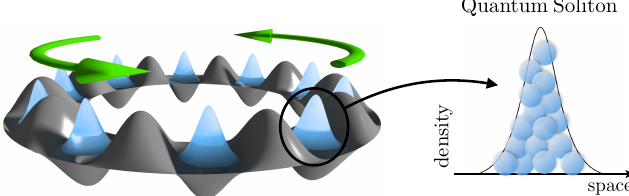
Figure 1: Schematic representation of the system. Left: Ring lattice of bosons with attractive interactions subjected to an artificial gauge field inducing matter-wave cur- rents (arrows). Attractive interactions give rise to the formation of many-body bound states, i.e. quantum analogs of bright solitons, where many particles are clustered together